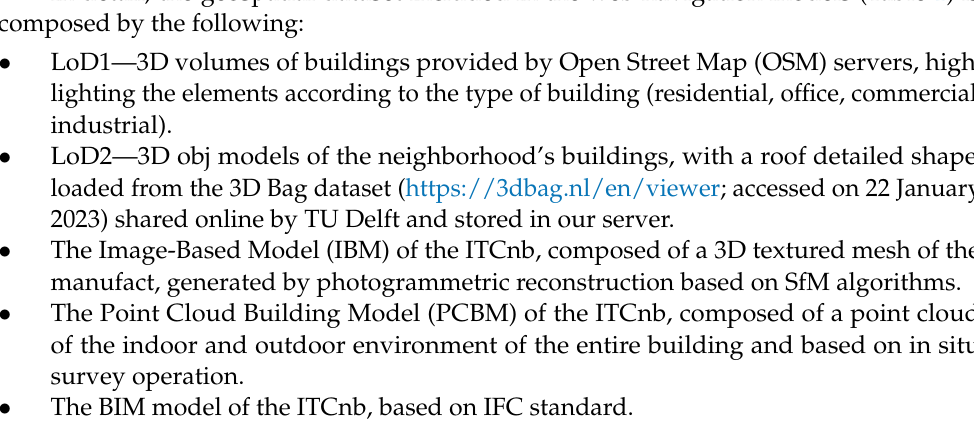
Table 1. The composition of the